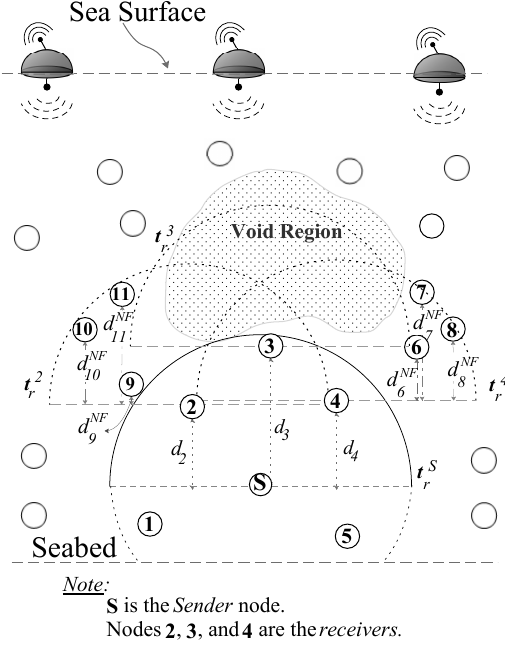
Figure 3. WDFAD-DBR routing